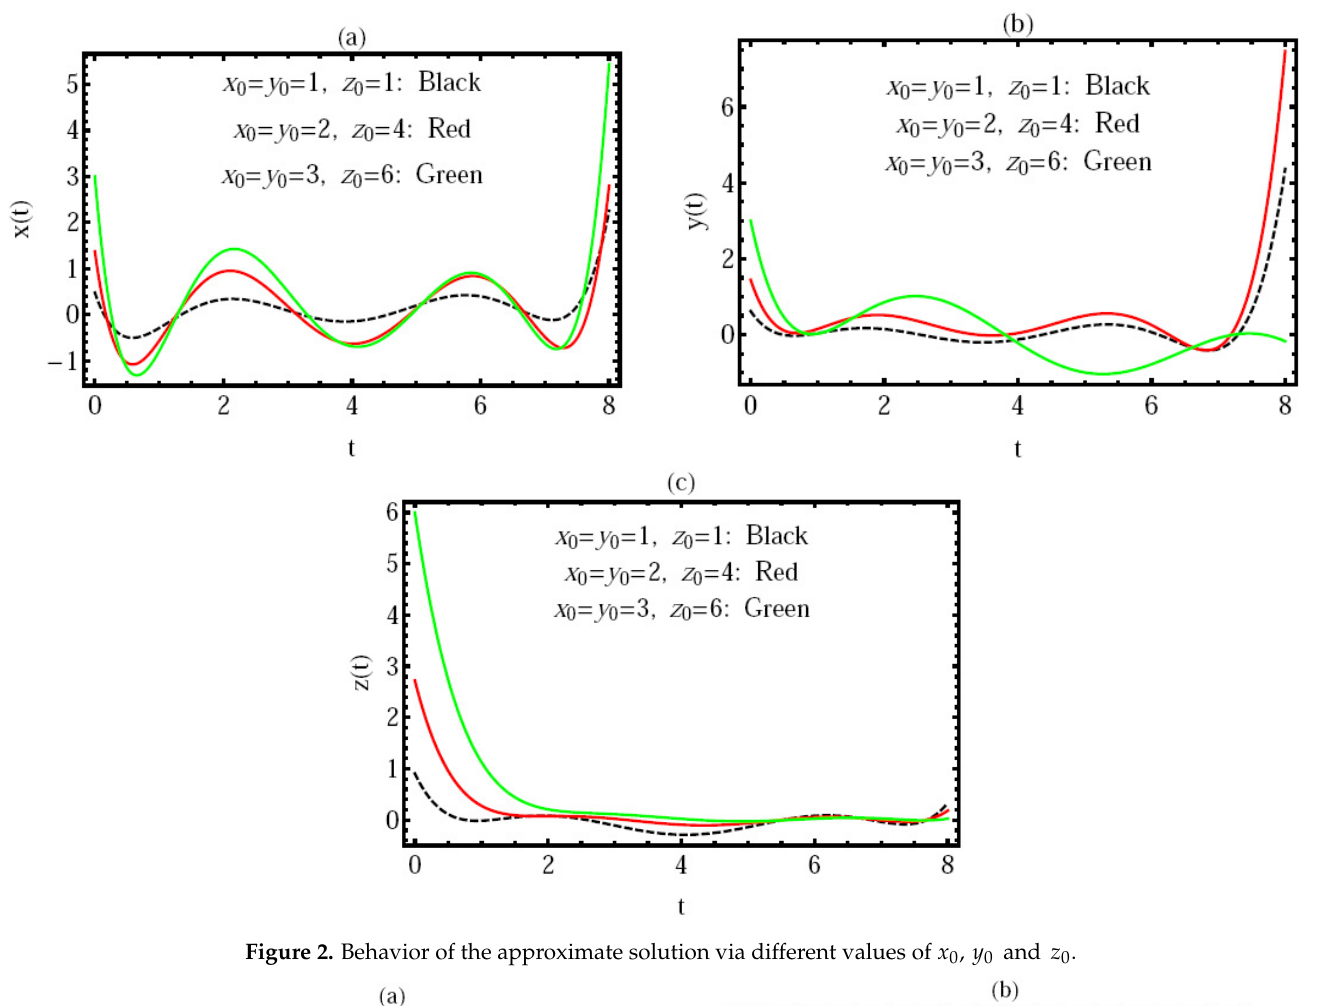
Figure 2. Behavior of the approximate solution via different values of x 0 , y 0 and z 0 .